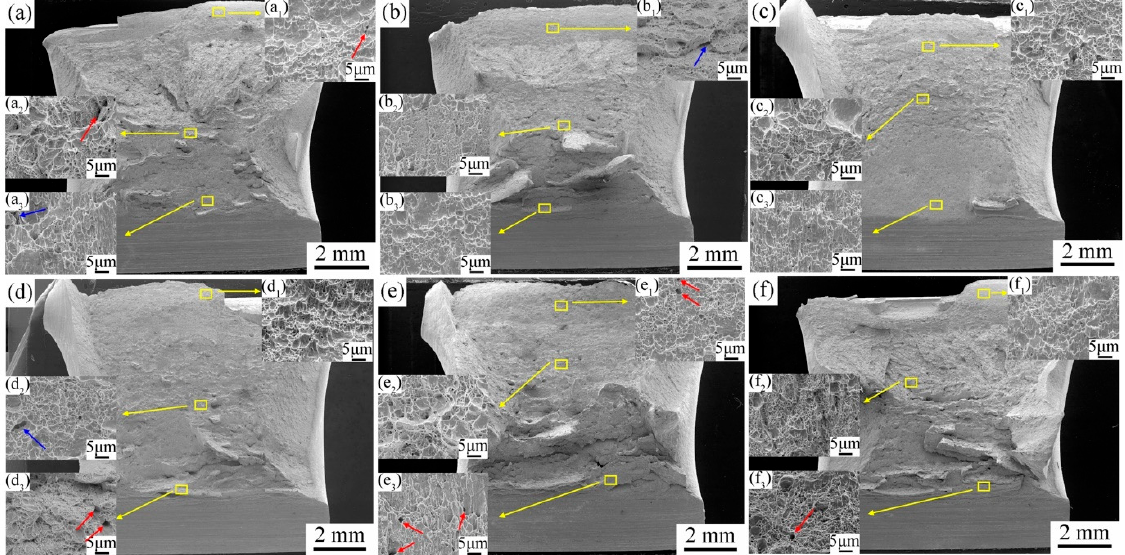
Figure 7. SEM micrographs of impact specimens after different heat treatments. ( a ) WQ, ( b ) QT400, ( c ) QT450, ( d ) QT500, ( e ) QT550, ( f ) QT600.